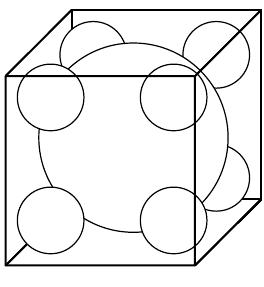
Figure 9. Spherical equivalent source.